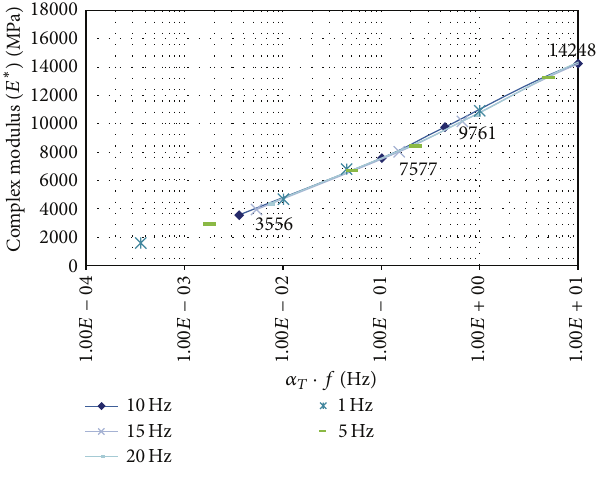
Figure 3: Main curves for AC 11;